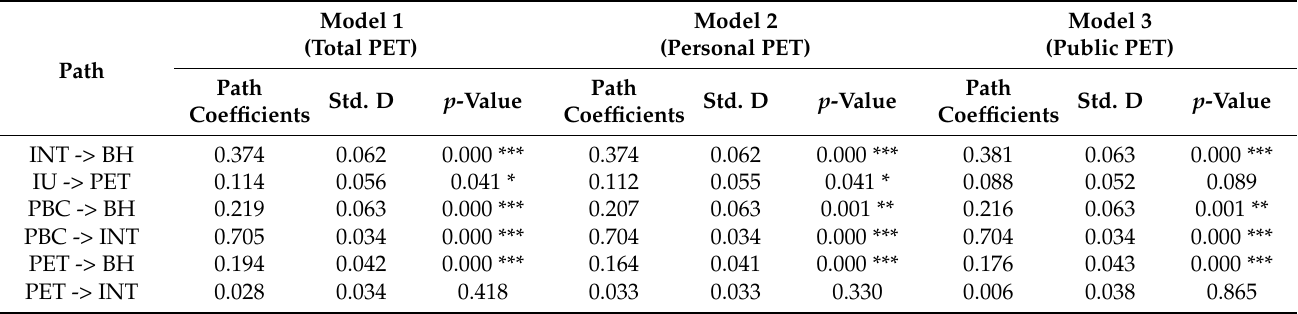
Figure 2. Research Model and Structural Results (Note: *** p < 0.001, * p < 0.05). Table 5. Results of Structural